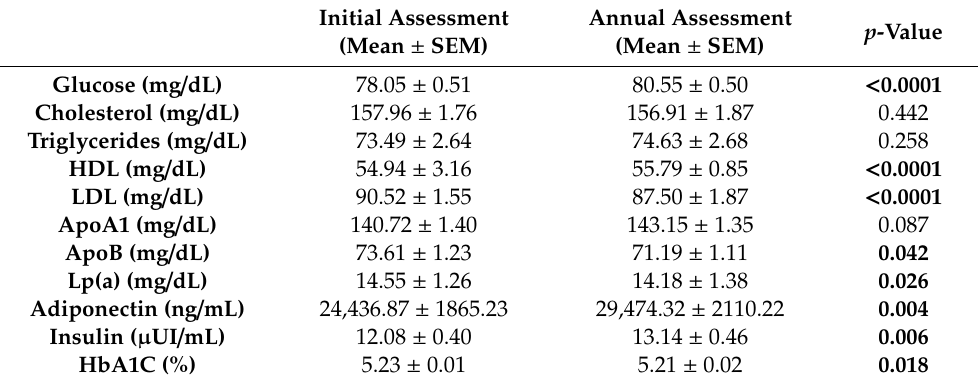
Table 6. Biochemical and endocrinologic parameters in subjects with overweight.